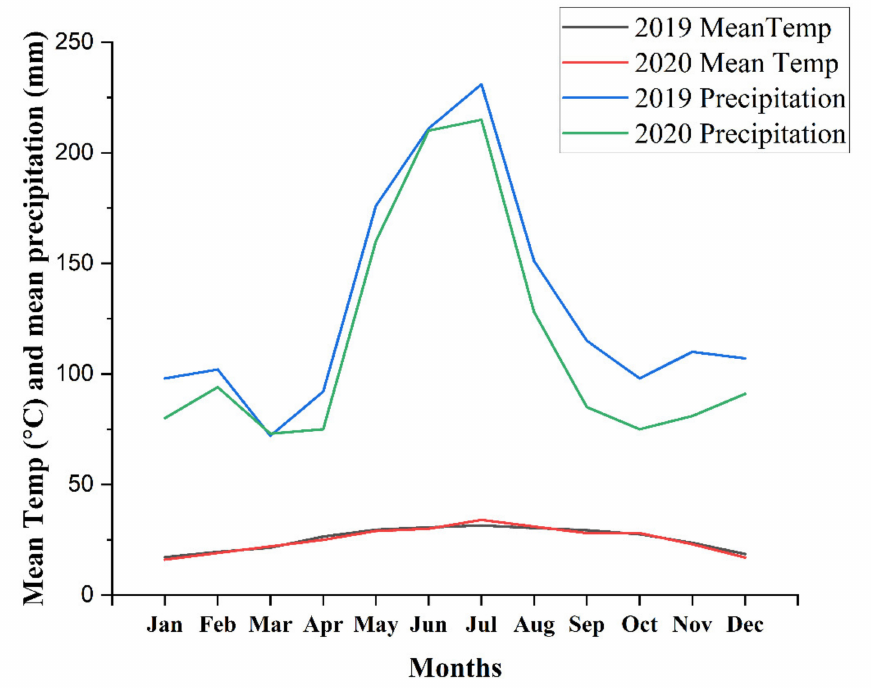
Figure 1. Mean temperature and mean precipitation of the experimental site during both